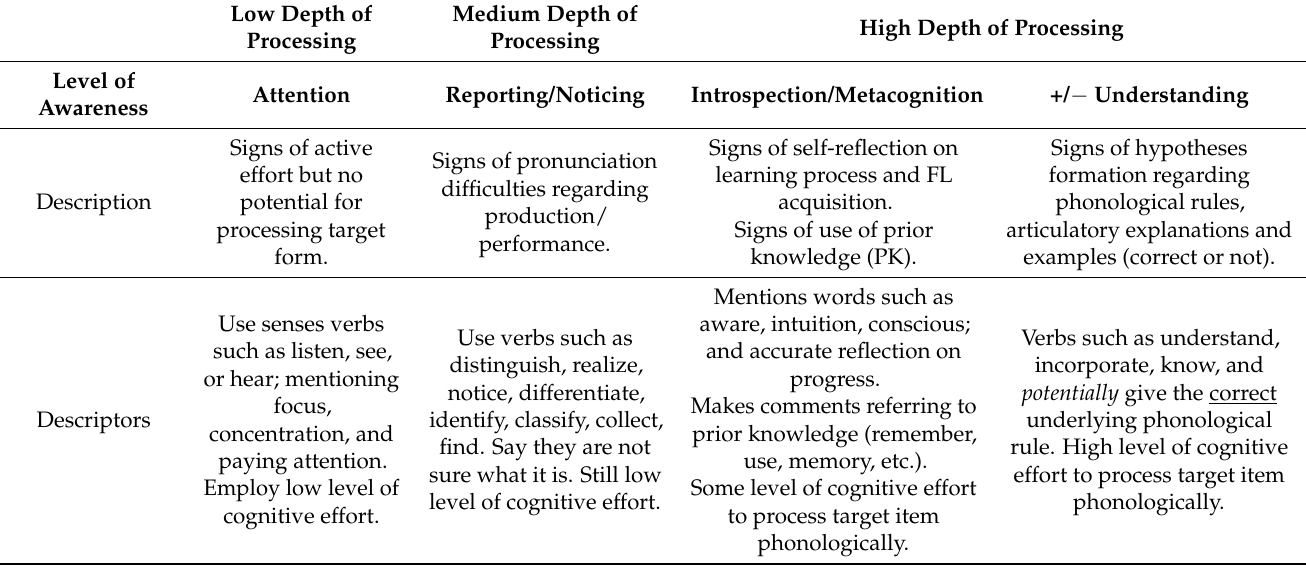
Table 4. Operationalization of Depth of Processing and coding procedure for participants’ self-reflections (adapted from Wrembel (2013, 2015); Leow (2015), and Meritan and Mroz